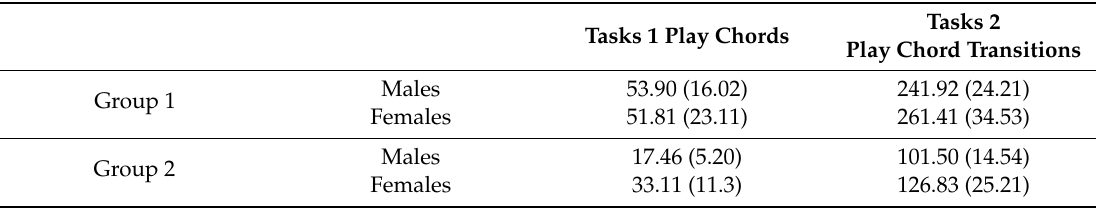
Table 4. Summary of statistical description of data by group and